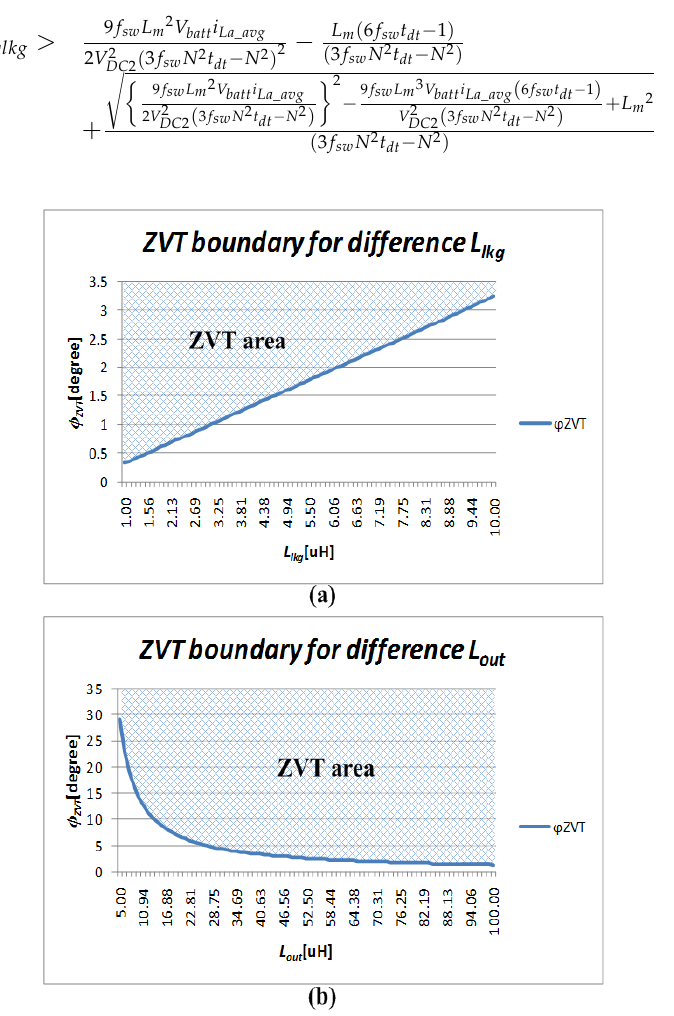
Figure 10. ZVT areas of the secondary side according to ( a ) leakage inductance and ( b ) output